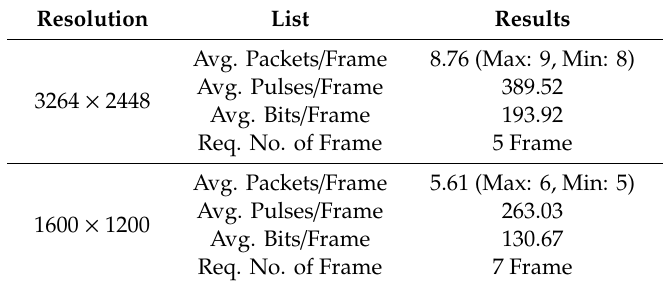
Table 2. Received streaming data consisting of 26 fragmented packets (sequential